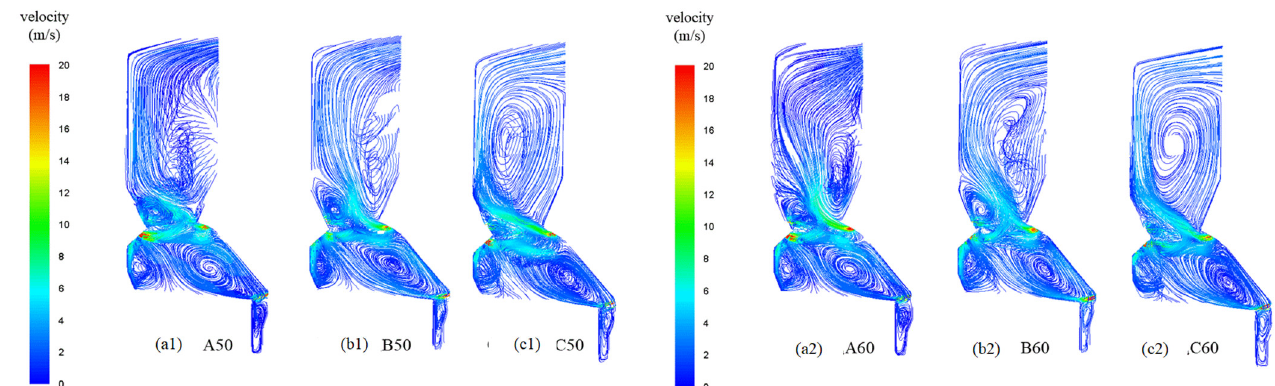
Figure 6. Velocity nephogram of vertical section at the grate tail.